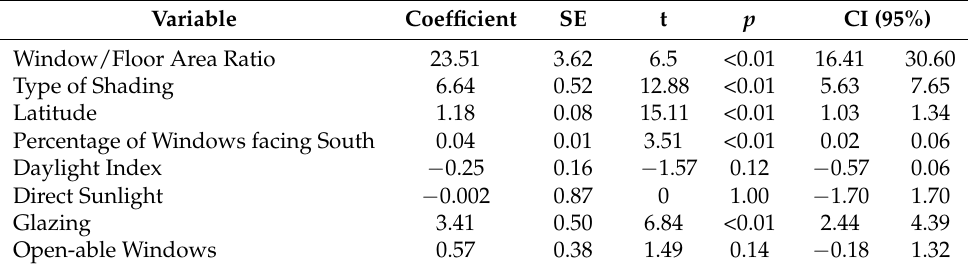
Table 3. Strength and significance of the association between the continuous lighting indicators and the performance test mean score. The coefficient represents the strength of